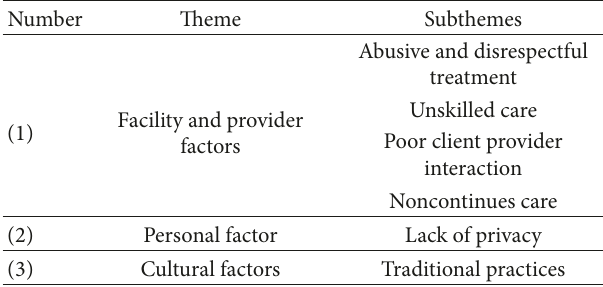
Table 1: Categories of themes and